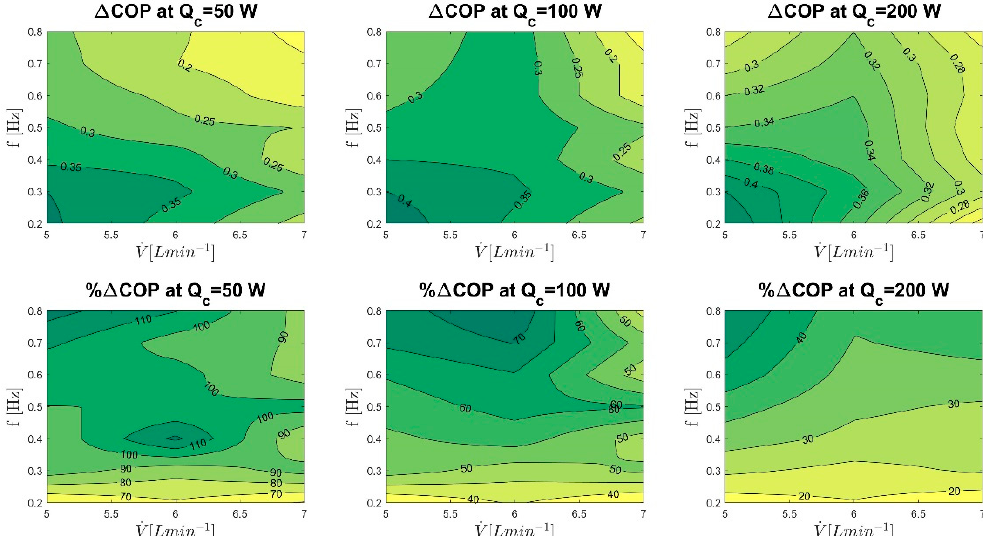
Figure 17. ‘8MAG’ COP changing by reducing thermal losses in the rotary valve for different operating conditions at T H = 22 °C. Temperature spans are in the range between 1 K and 8.5 K.